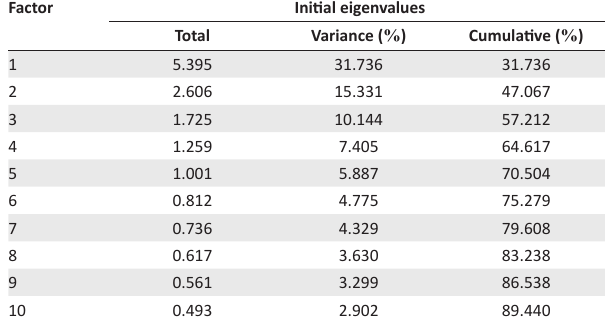
TABLE 5: Extract table of factor analysis for media richness.